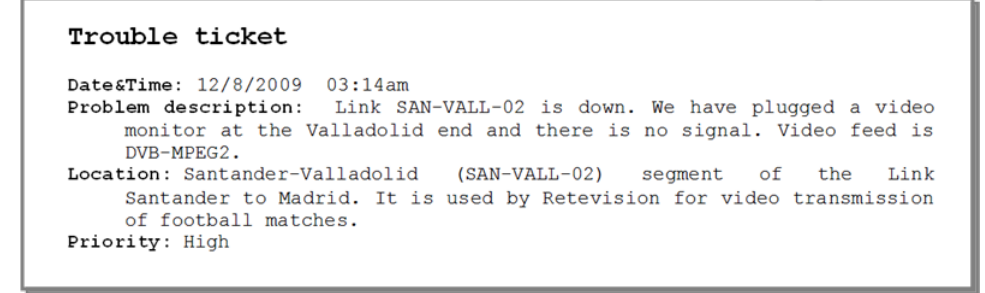
Fig. 3.: Example of trouble ticket sent to the students with a particular